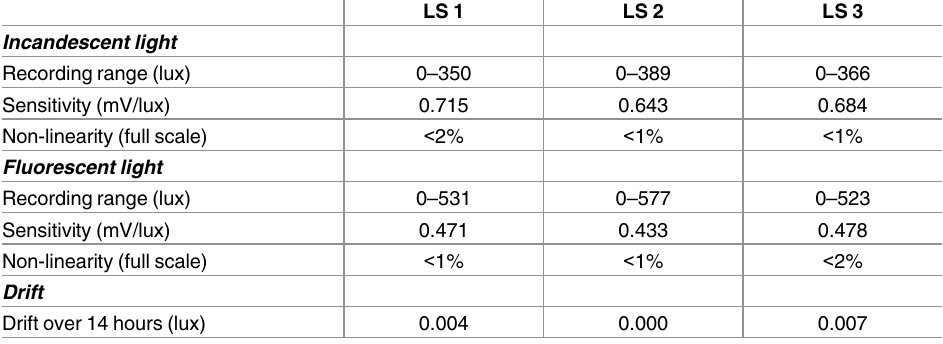
Table 1. Light sensor (LS) trace characteristics for incandescent and fluorescent